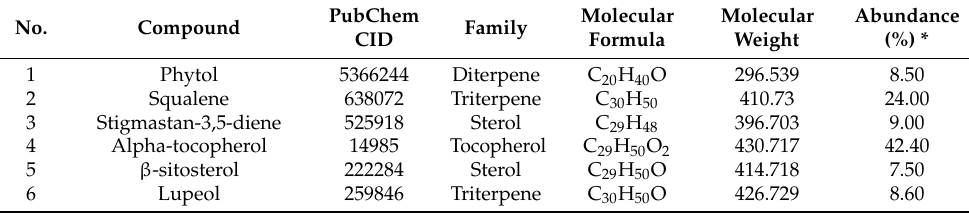
Table 1. The chemical composition of acetone extract from F. crocata (Ace-EFc).